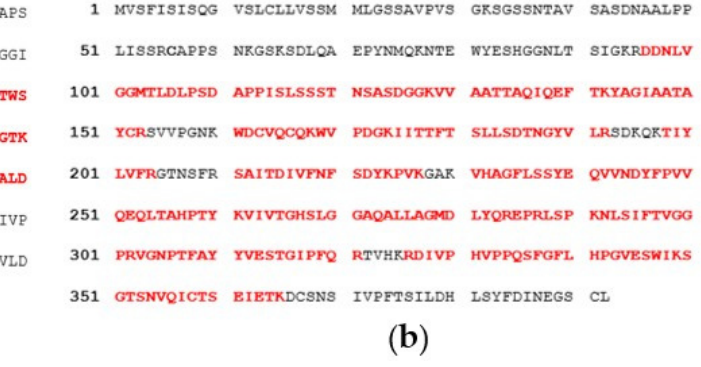
Figure 2. MS/MS analysis of lipases RML and ROL. Matched peptides between digested lipases samples and in silico digestions of lipases sequence from Swiss-Prot are shown in red, whereas the remaining part of the complete sequence is shown in black. ( a ) RML sample and RML sequence P19515; ( b ) ROL sample and ROL sequence P61872.